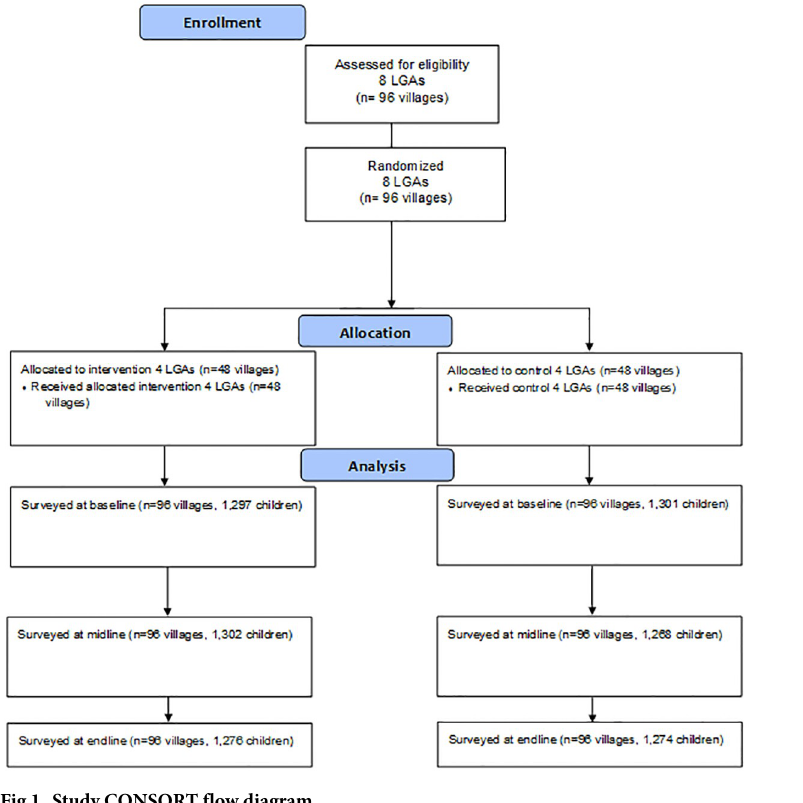
Fig 1. Study CONSORT flow